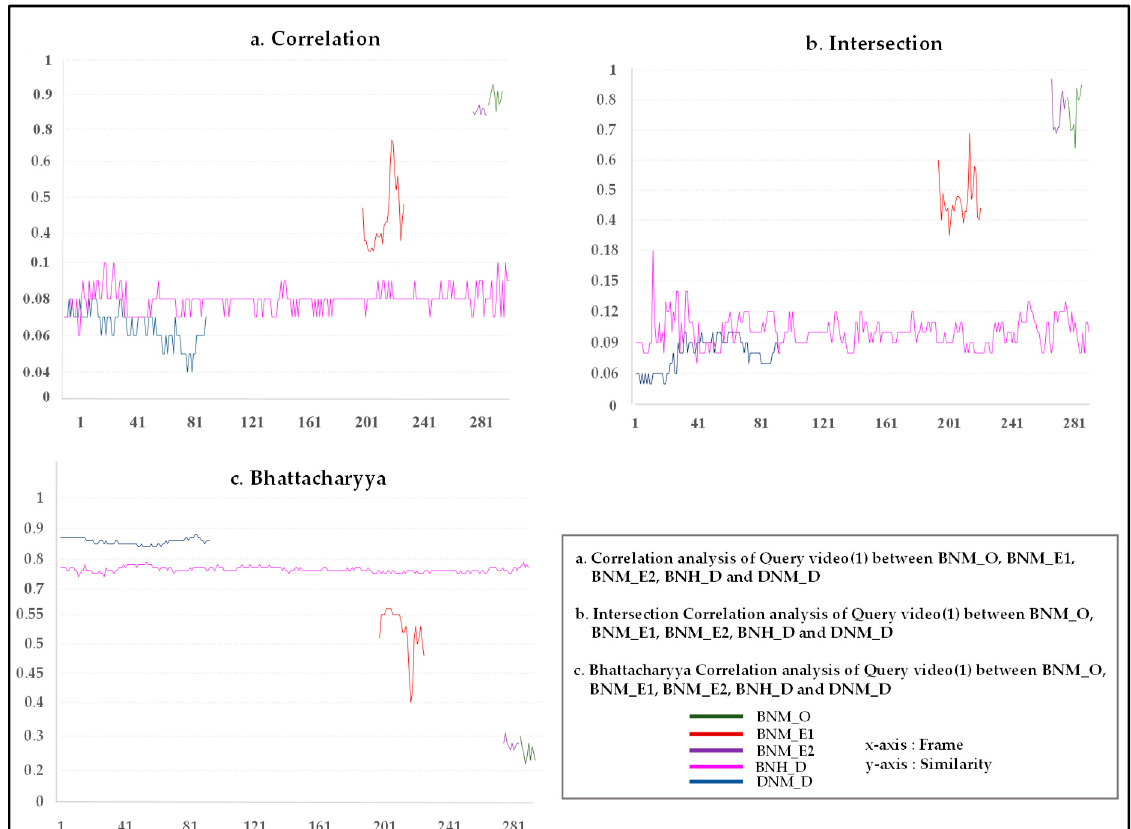
Figure 10. Algorithm for similarity comparison between Query video_1 and other videos (scenario 2).